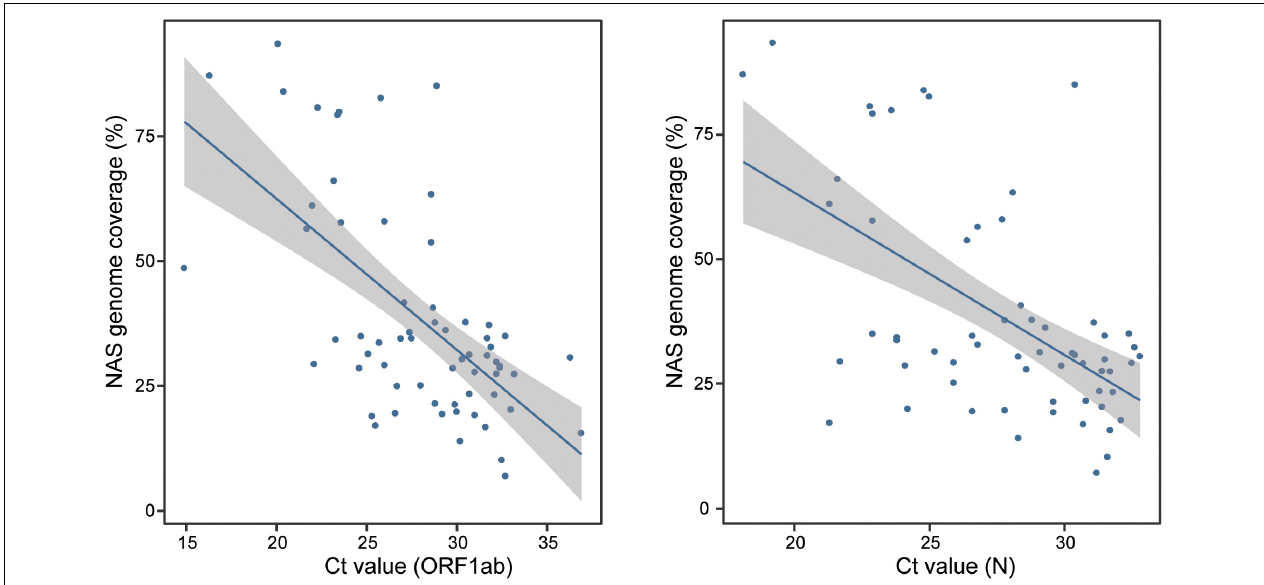
FIGURE 2 | Consistency of the genome coverage of NAS and the C t value of RT-qPCR detection of the ORF1ab and N genes. NAS , nanopore amplicon sequencing; C t , cycle threshold; RT-qPCR , reverse transcription quantitative polymerase chain reaction.